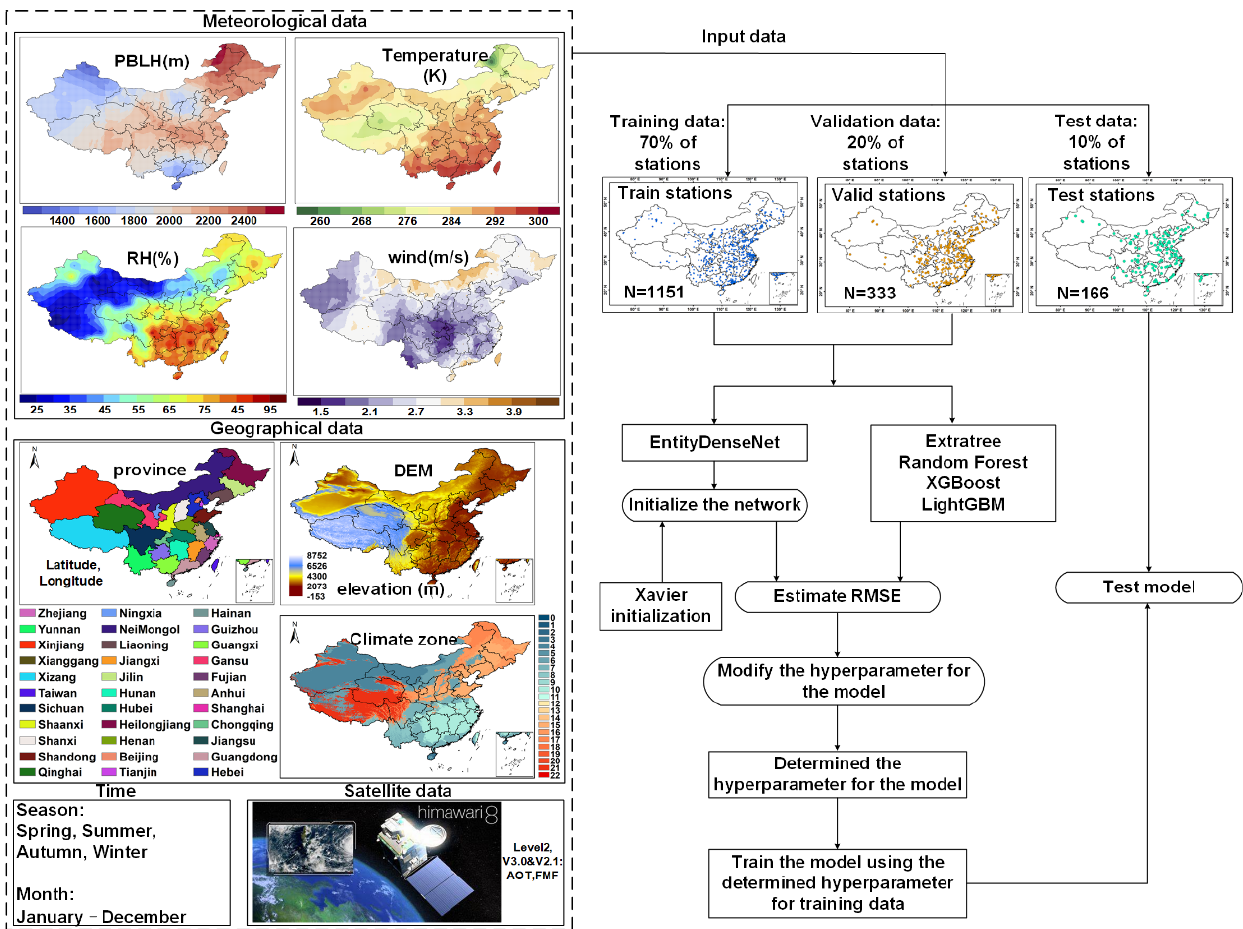
Figure 3. Flowchart of the entire training process for both EntityDenseNet and the four traditional machine learning models. The distributions of meteorological data were interpolated by the Kringing method using averaged values in 2020 over meteorology stations (for temperature, relative humidity (RH), and wind speed) and radiosonde stations (for the boundary layer height (PBLH)) in China.